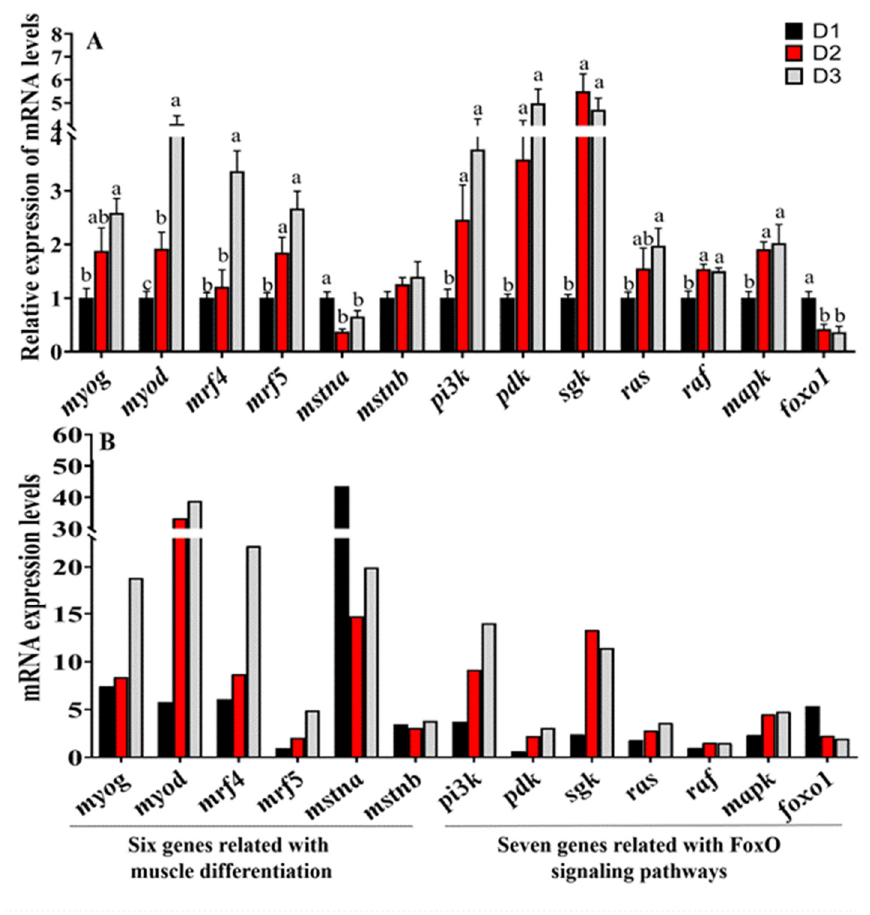
Figure 4. The gene expression profile was verified by qRT-PCR. The relative expression trends between RNA-seq and qRT-PCR of the genes related to muscle differentiation and FoxO signaling pathways were completely consistent. ( A ) is qRT-PCR results; ( B ) is RNA-Seq results. Values are expressed as means ± SEM (n = 3). Bars among each gene with different letters indicate significant differences. ( p < 0.05).